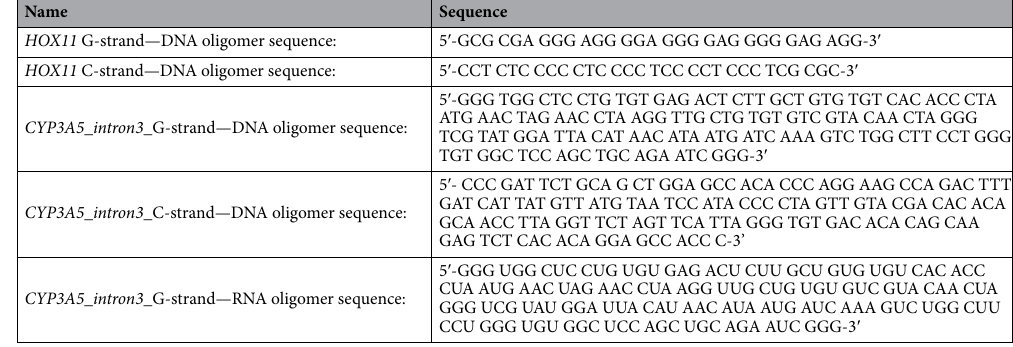
Table 2. DNA and RNA oligomers used in gel shift mobility